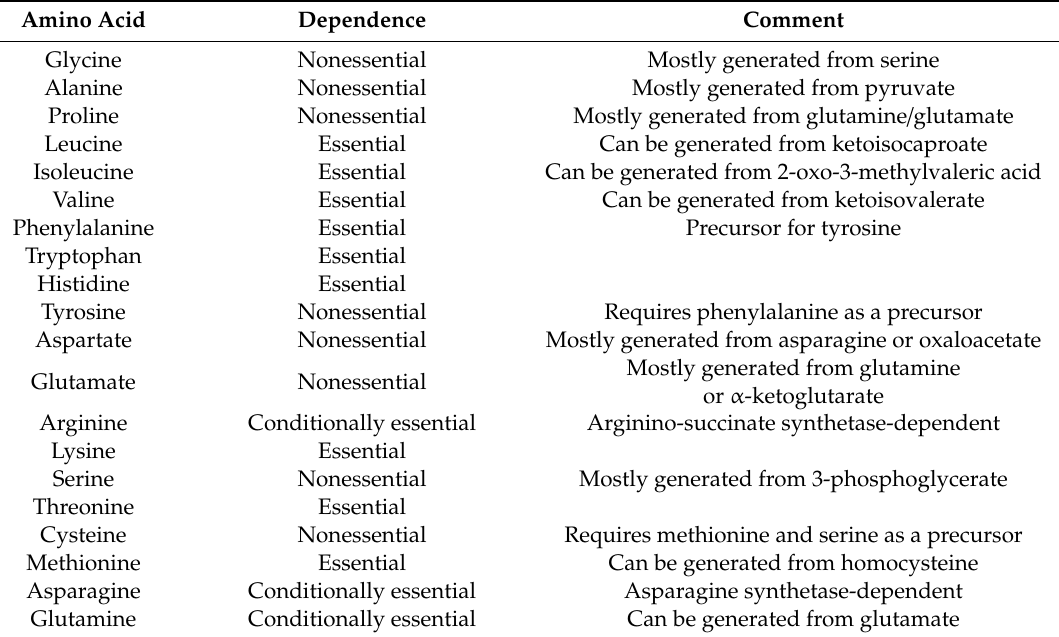
Table 1. Essential and nonessential amino acids in cancer